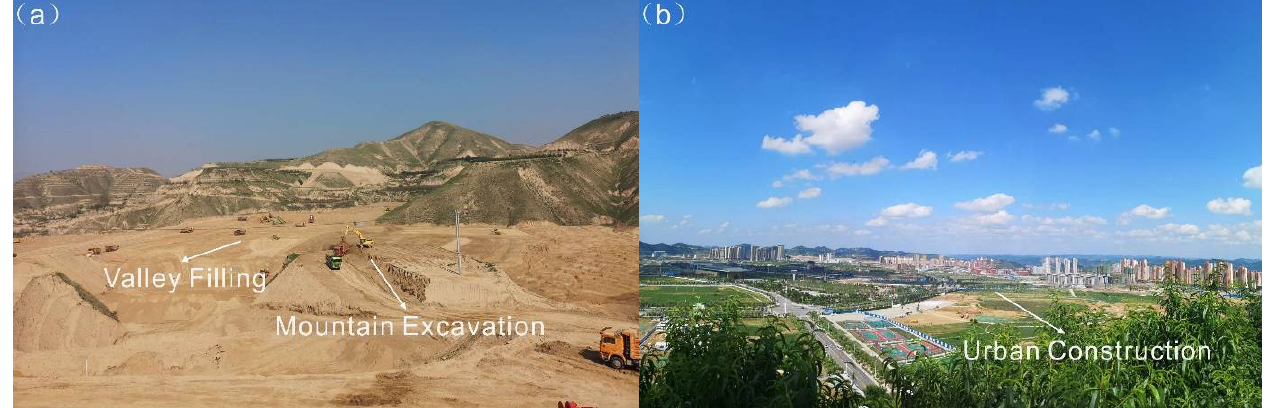
Figure 1. Mountain excavation and city construction in the YND. ( a ) Land creation in the loess hilly region; ( b ) Urban construction in the land-creation area.